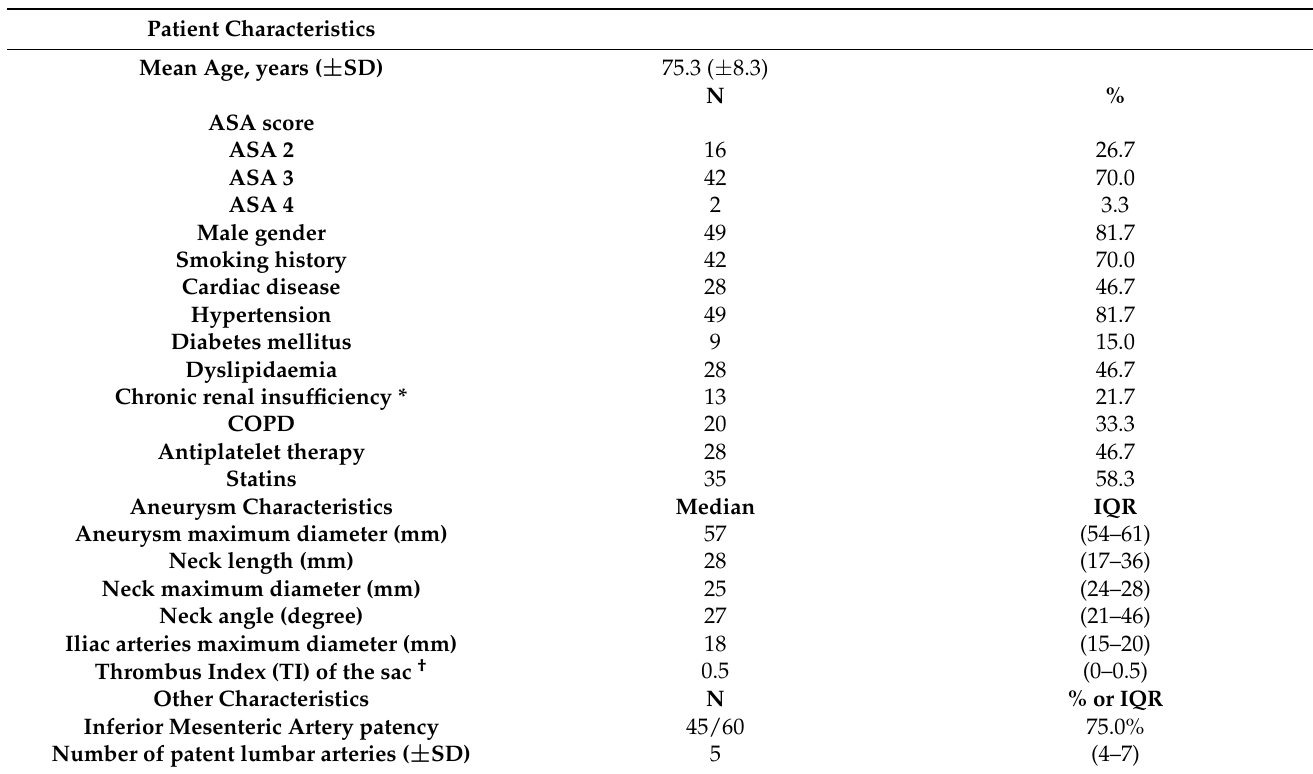
Table 1. Main characteristics of 60 patients undergoing EVAR for infrarenal aortic aneurysm.